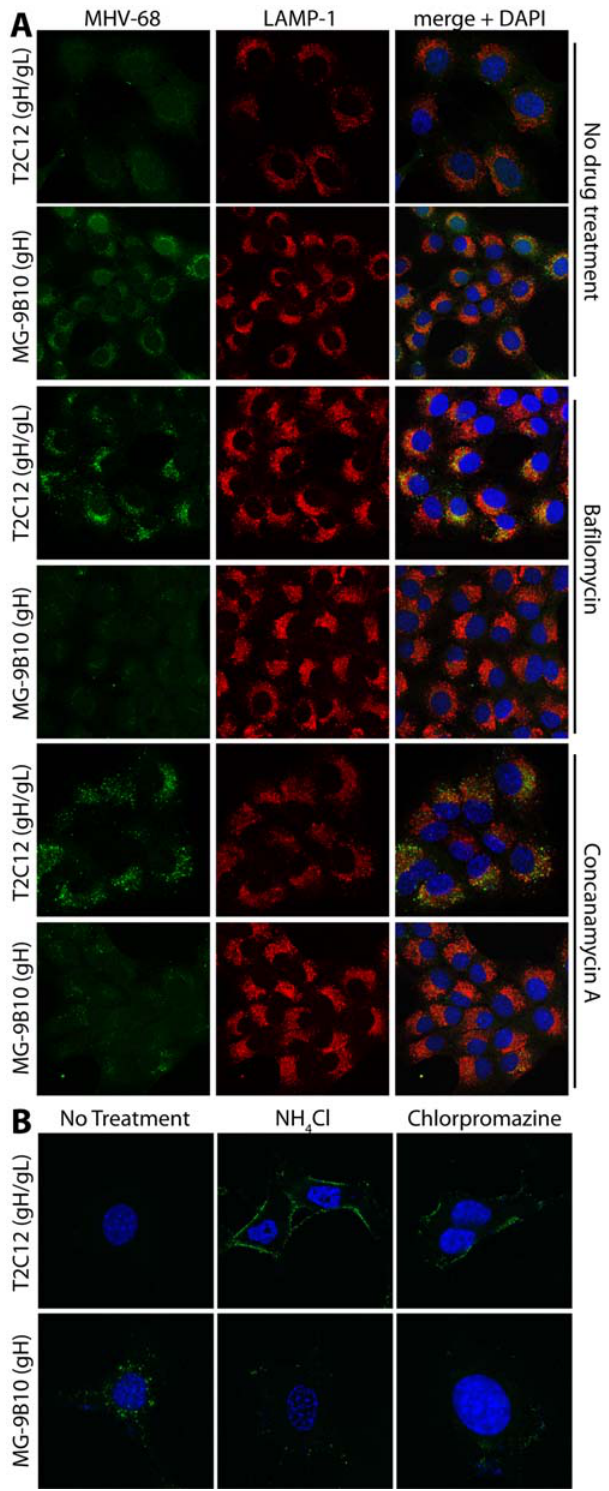
Figure 2. The gH/gL conformation change is pH-dependent. A. MuHV-4 virions were bound to NMuMG cells (2 h, 4 u C) with or without bafilomycin (500 nM) or concanamycin A (1 m M). The cells were then washed in PBS to remove unbound virions, further incubated with or without drugs (2 h, 37 u C), fixed, permeabilized and stained for gH or gH/gL plus LAMP-1. Nuclei were counterstained with DAPI. B. In a similar experiment, MuHV-4 virions were bound to NMuMG cells (2